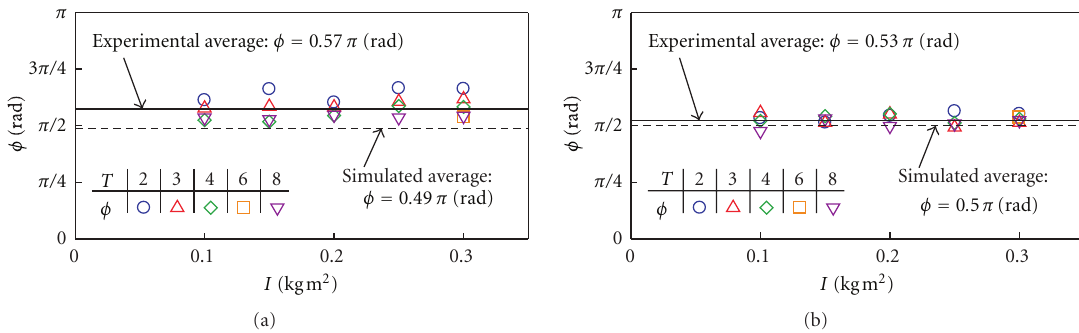
Figure 9: Phase delay, φ , for wind amplitude (a) Δ V = 1 and (b) Δ V = 2m/s.